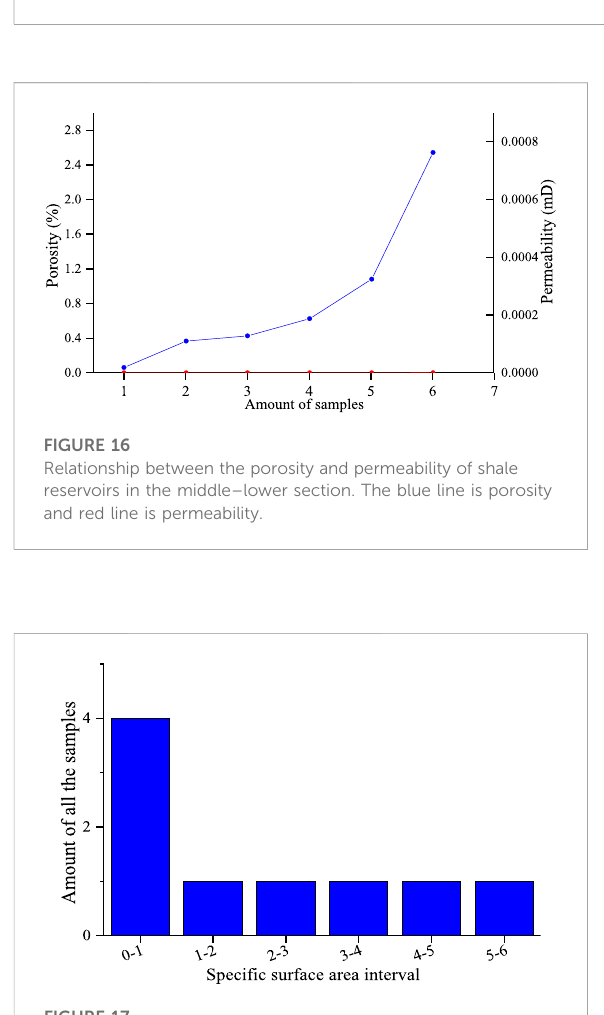
FIGURE 17 Distribution frequency ofthespeci fi csurfacearea indifferent intervals of shale reservoirs in the middle and lower